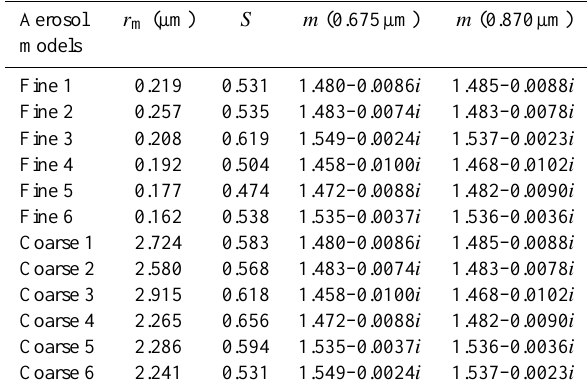
Table 3. Detailed parameters of fine model and coarse